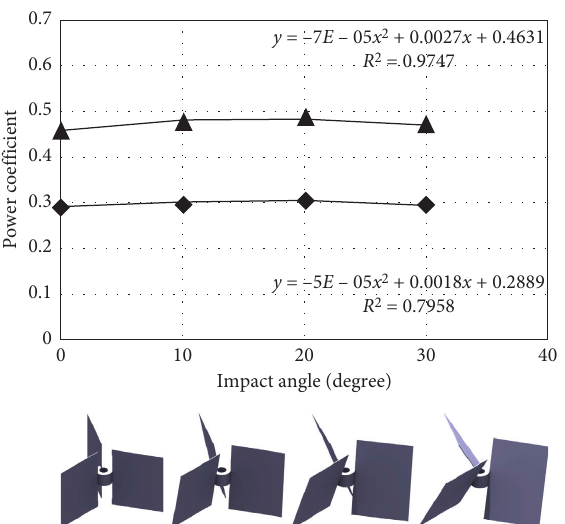
Figure 13: Set 3 data points (left to right—runners R3, R8, R9, and R10).